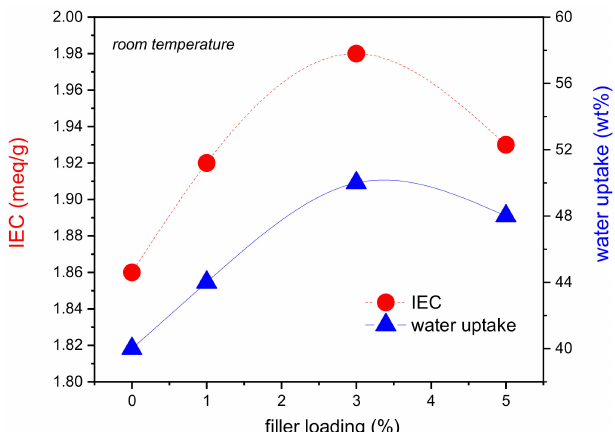
Figure 3. Ion exchange capacity and water uptakes of sPEEK/PSLM composite membranes as a function of the filler loadings.